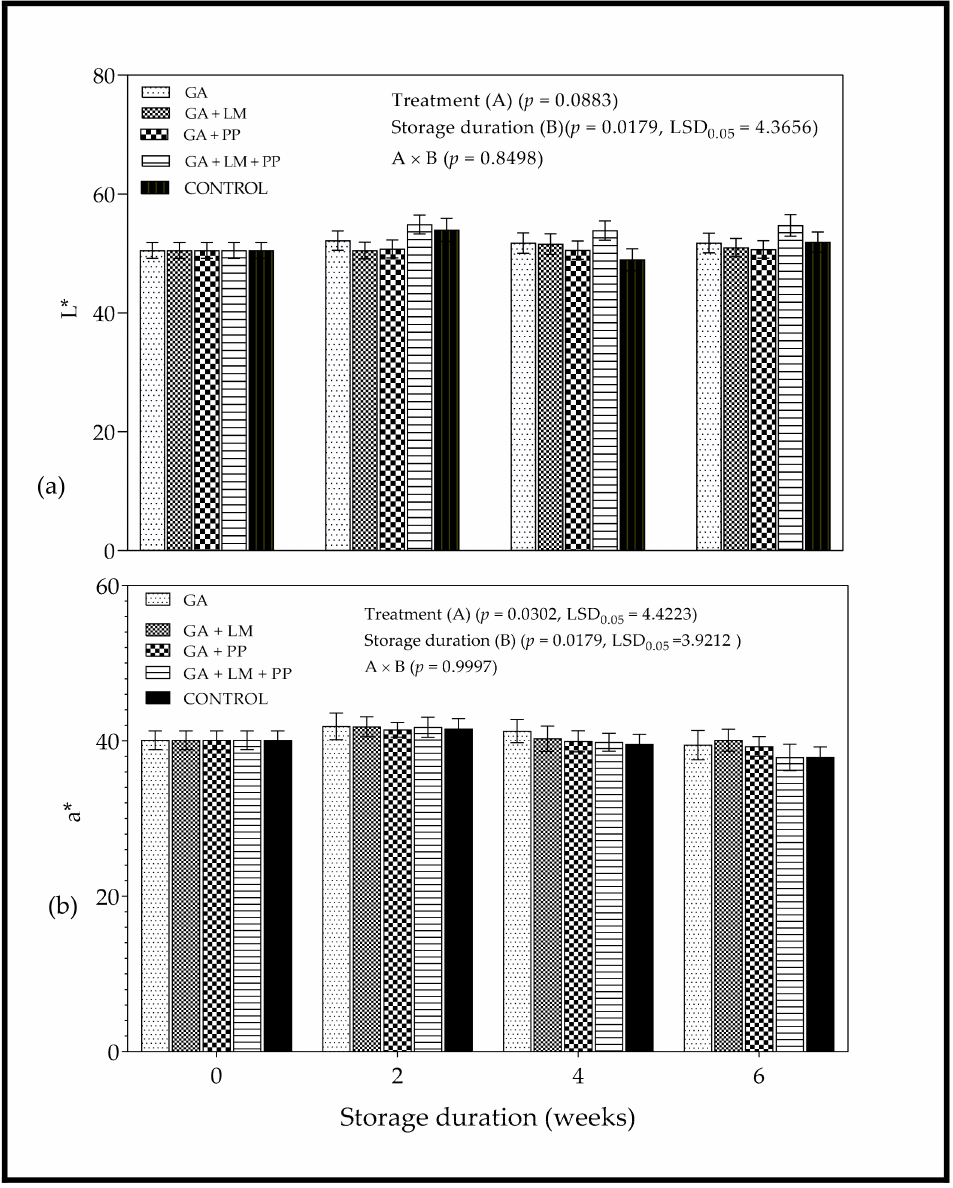
Figure 6. Color attributes ( a ) lightness (L*) and ( b ) redness (a*) of ‘Wonderful’ pomegranate whole fruit coated with gum arabic (GA) coatings enriched with lemongrass oil (LM) (0.1% v/v ) and/or pomegranate peel extract (PP) (0.1% w/v ) and stored at 5 ± 1 ◦ C (95 ± 2% RH) for 6 weeks. Vertical bars represent the standard error (SE) of mean value calculated from 10 measurements per treatment (1 fruit = 1 measurement). LSD 0.05 represents least significant difference ( p <